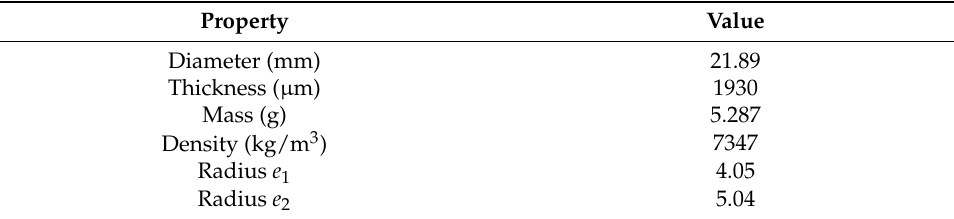
Table 1. Measured values of resonator properties.